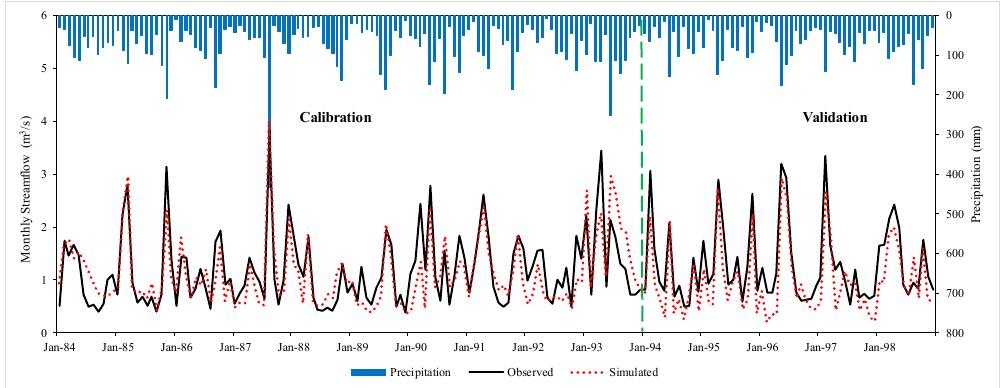
Table 8. Statistical indicators for c alibration and validation periods for streamflow and baseflow in the UWBDR watershed and Walzem Creek watershed.